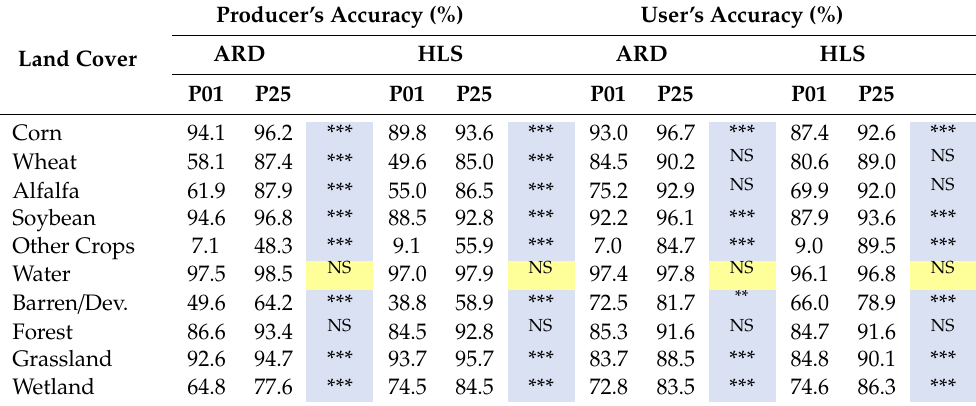
Table 7. Producer’s and user’s accuracies (in percent) of 2016 RFC models using P01 and P25 sample sizes. Significance levels of the U test (P01 < P25) across rows are indicated by ***, **, and * for p-values of less than 0.001, 0.01, and 0.05, respectively. NS stands for “not significant”. Results of the TOST equivalence tests across rows are highlighted in light blue for “not equivalent” and light yellow for “equivalent”.